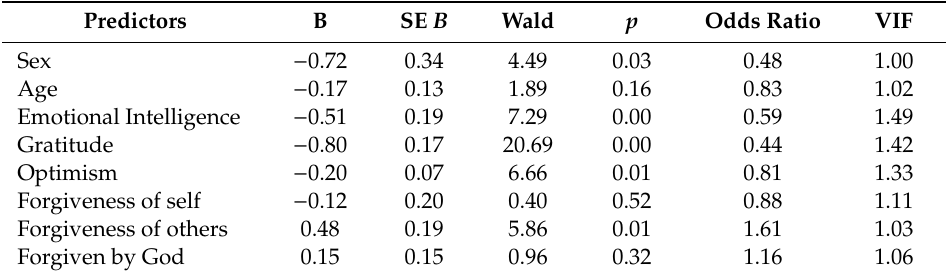
Table 3. Identification of positive personal resources distinguishing depressive symptomatology ( n = 89) and non-depressive symptomatology ( n = 162) group membership: logistic regression analysis. Predictors B SE B